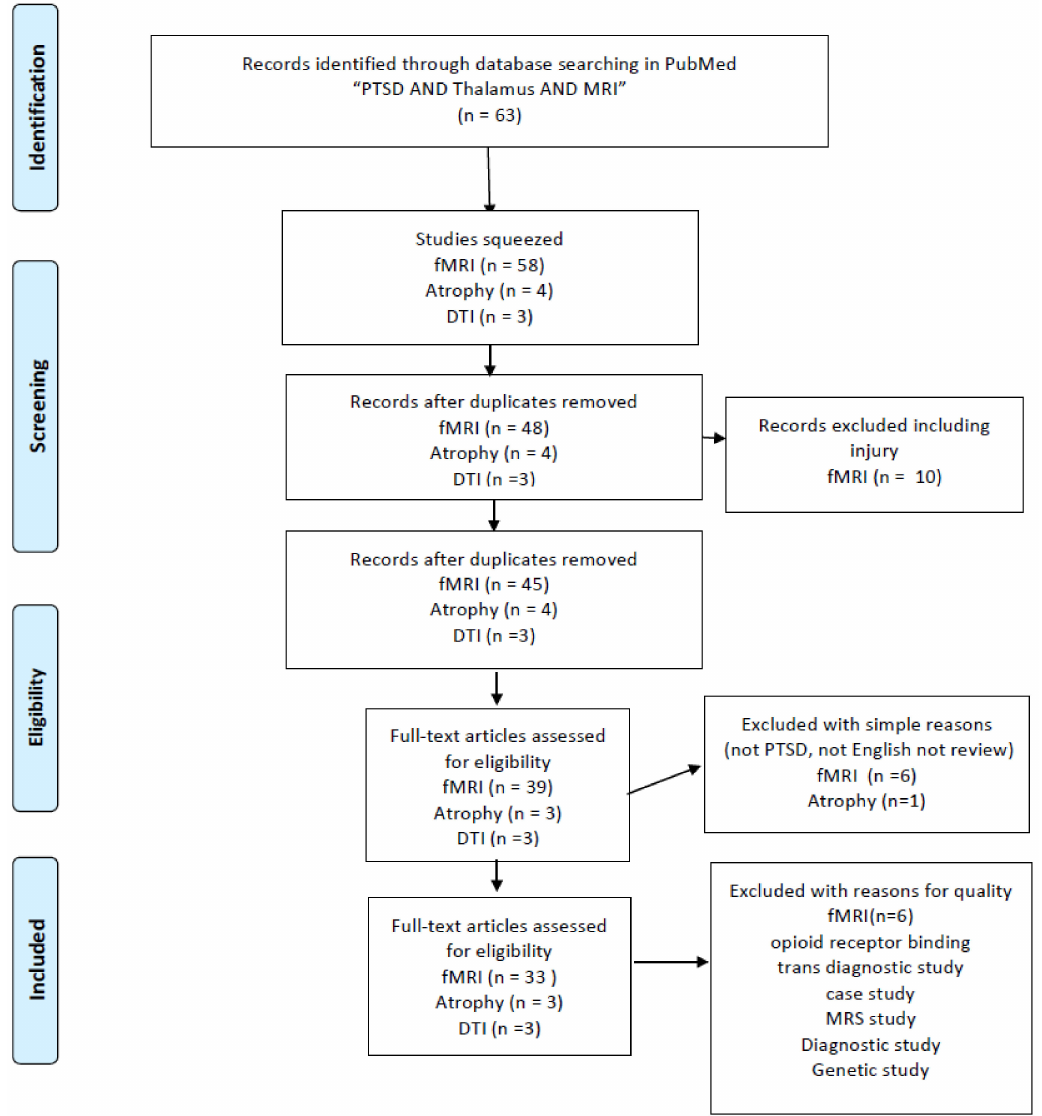
Figure 1. PRISMA flow diagrams [25] of literature research for PTSD neuroimaging research targeting on the